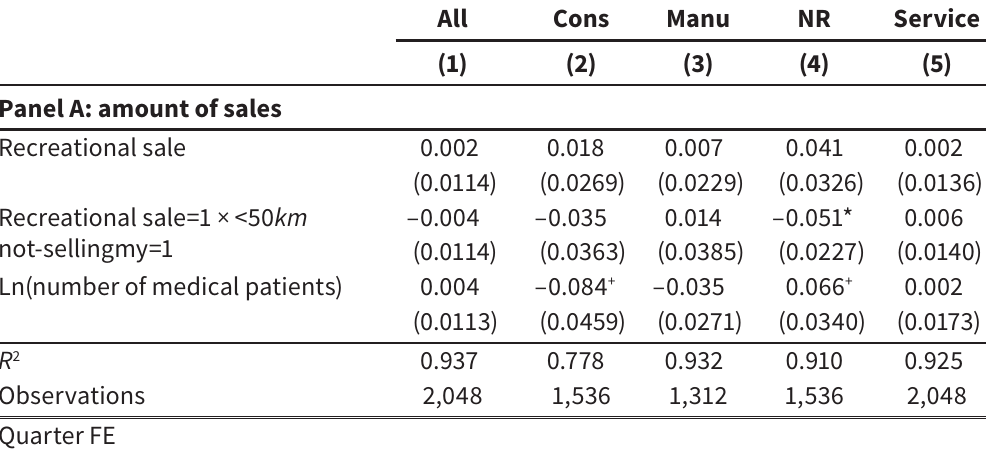
The effect of recreational dispensary entry and sales on wages – regression